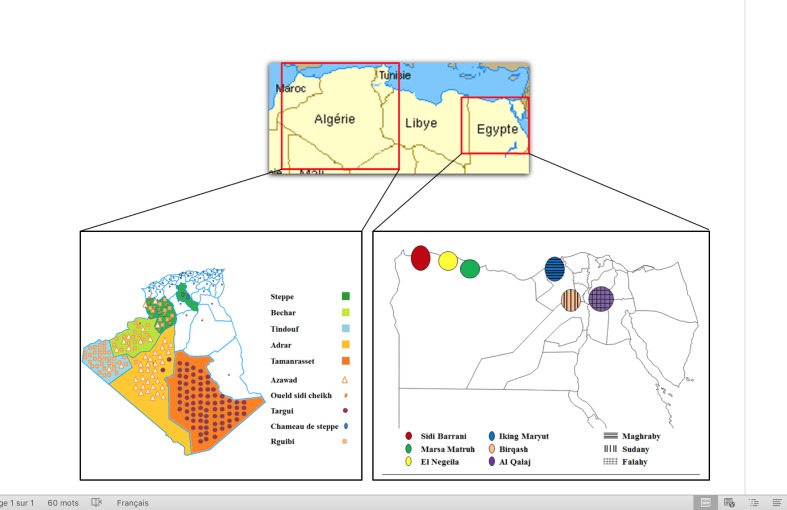
Geographic distribution of the Algerian and Egyptian dromedary samples analyzed in the study.